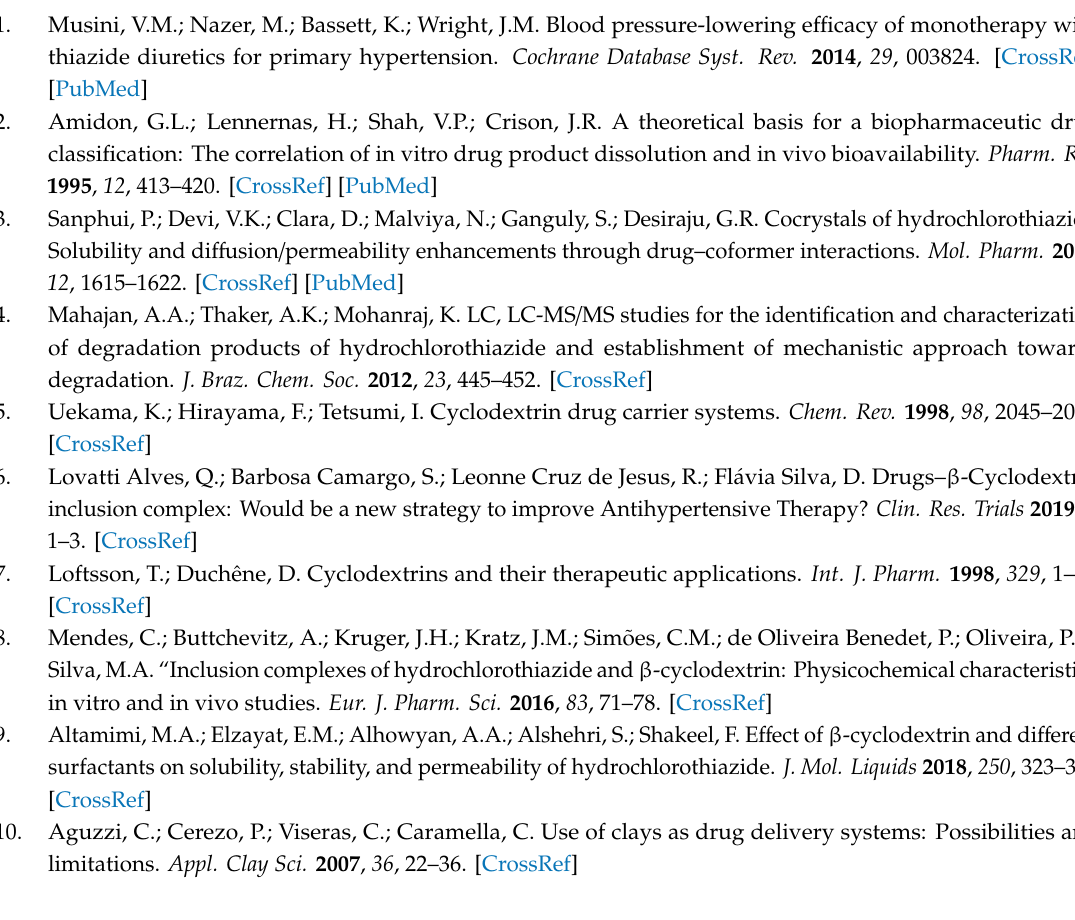
Figure S1: XRPD patterns of COE products with SBE β CD (yellow line), HP β CD (grey line) and HE β CD (orange line); Figure S2: Compatibility studies for tablet